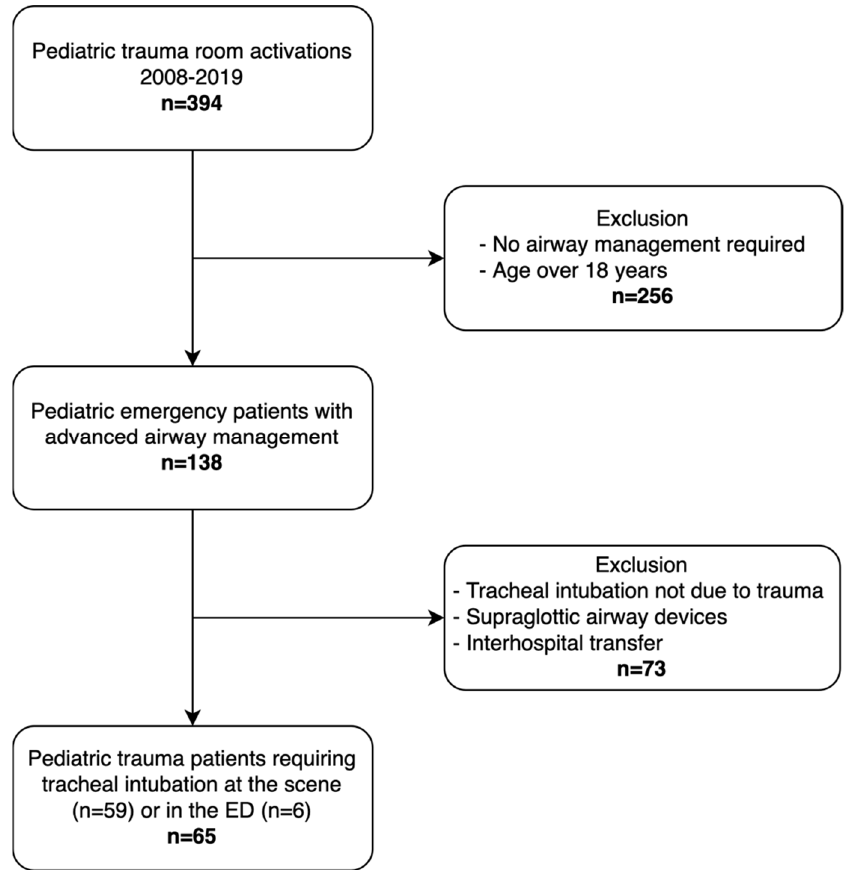
Figure 1. Study flowchart. Table 1. Baseline characteristics of the study cohort.